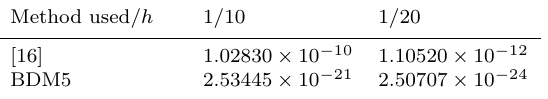
Table 8. Comparison of maximum absolute errors (MAE) on Example 3. Method used/